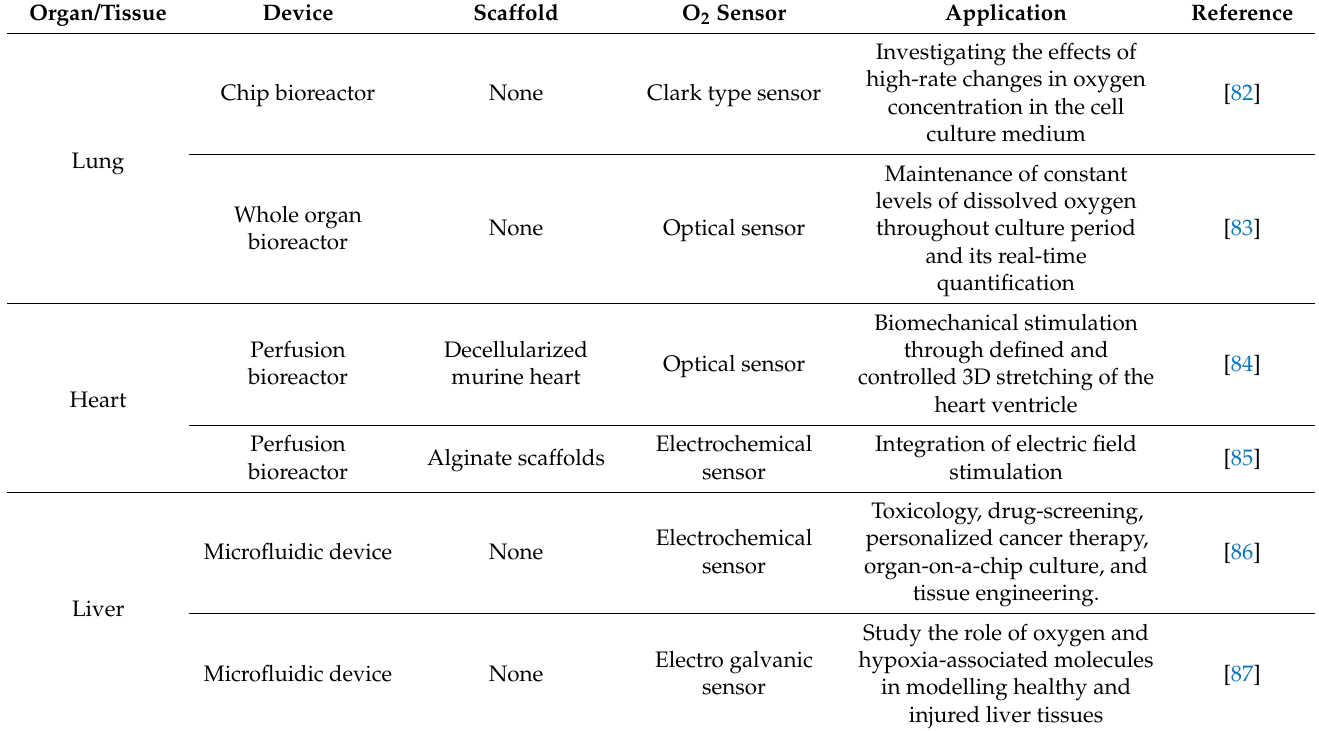
Table 1. Available bioreactors with real-time oxygen monitoring.